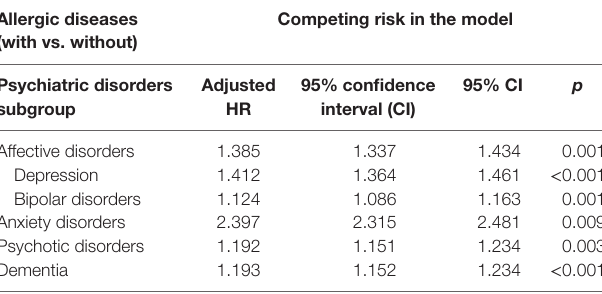
TaBle 4 | Hazard ratio (HR) of affective, anxiety, psychotic disorders, and dementia in patients with vs. without allergic diseases. allergic diseases (with vs.